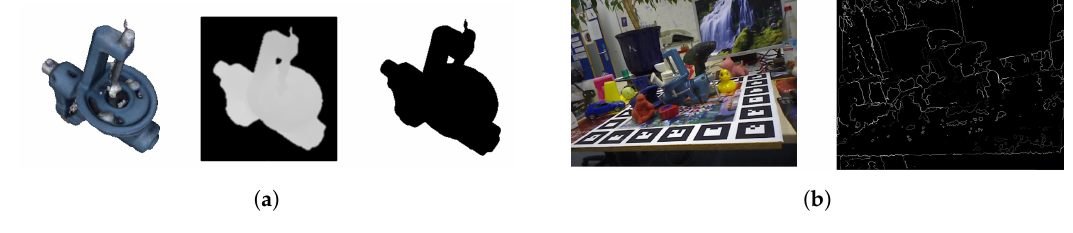
Figure 9. Examples of the extraction of the object model silhouette and the scene edges. ( a ) object model silhouette; ( b ) scene